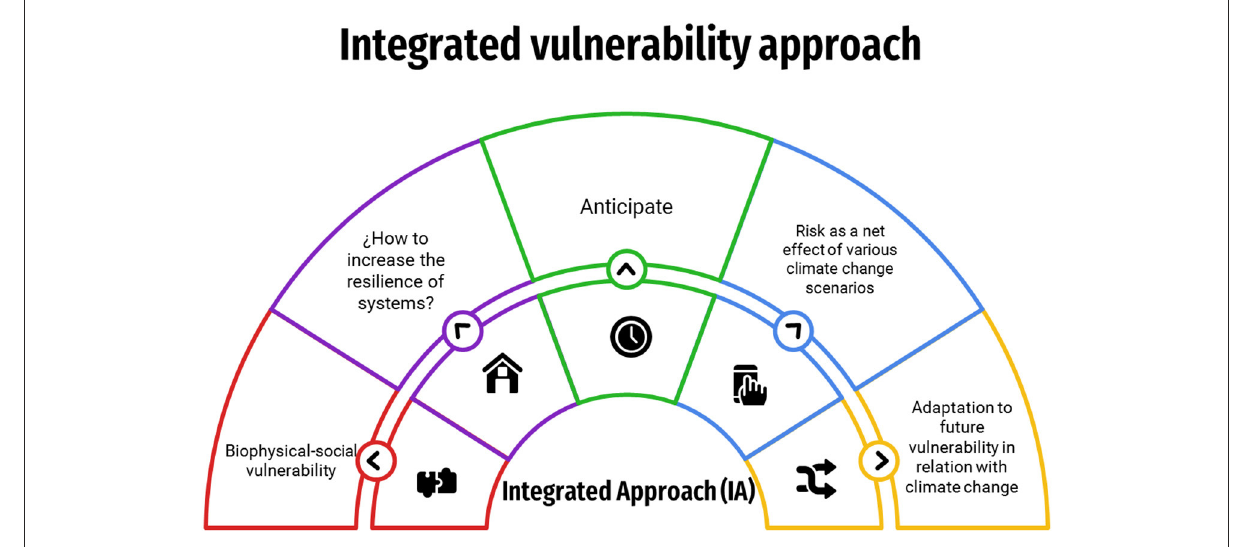
FIGURE2 An integrated vulnerability approach was created from Lampis (2013)